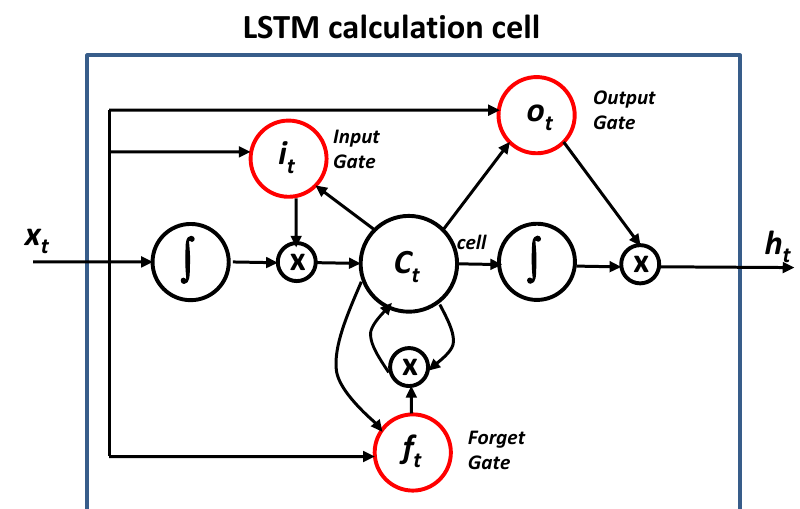
Figure 6. Long short-term memory (LSTM) calculation cell (symbol x represents the multiplication operator between inputs, and ∫ represents the application of a differentiable function).